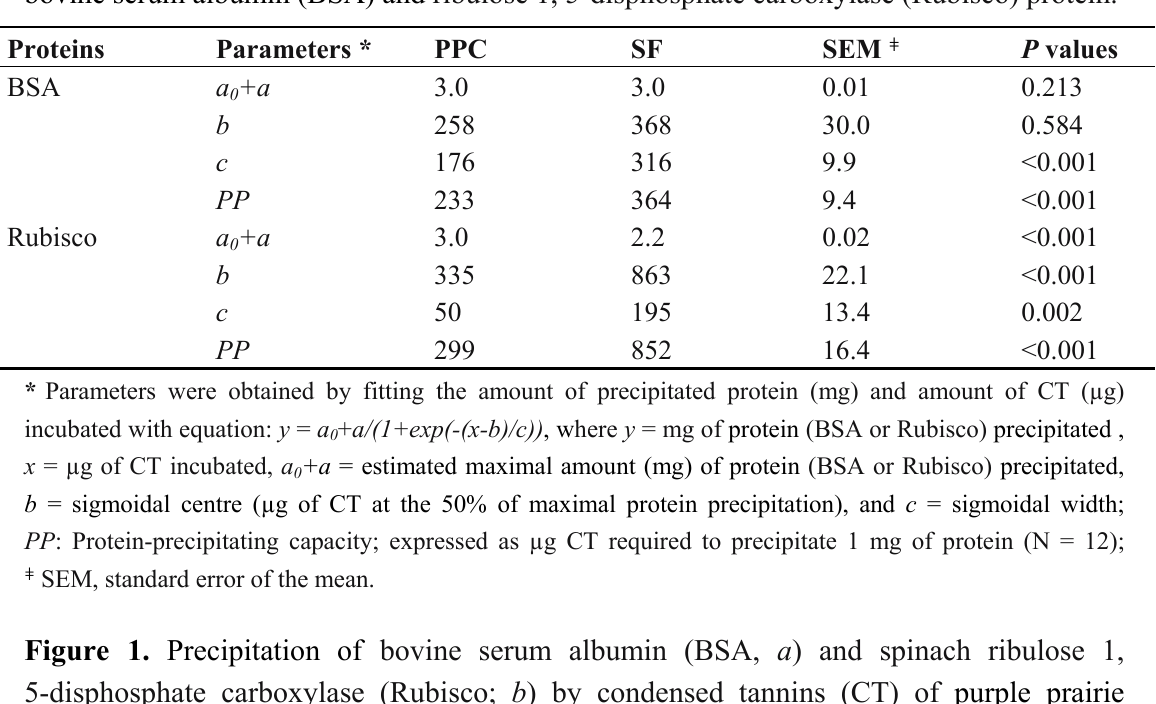
Figure 1. Precipitation of bovine serum albumin (BSA, a ) and spinach ribulose 1, 5-disphosphate carboxylase (Rubisco; b ) by condensed tannins (CT) of purple prairie clover (PPC; Dalea purpurea Vent.) and sainfoin (SF; Onobrychis viciifolia ). ♦ PPC CT; ∆ SF CT. Solid and dash lines relate to PPC and SF CT data, respectively which were fitted to sigmoidal curve as described in the text. Bars indicate standard error. Where not visible, bars fall within